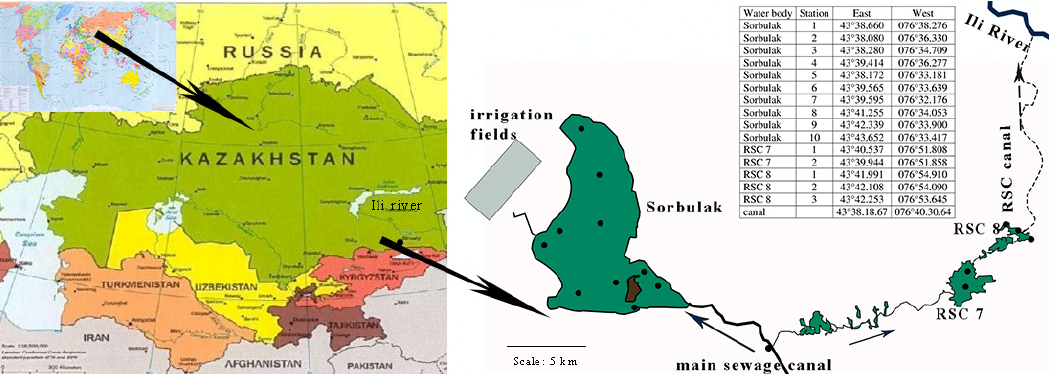
Figure 1. The layout and coordinates of sampling stations in wastewater reservoirs of the Right-Bank Sorbulak Canal system, 2021. Black circles are the sampling stations. The dotted line shows the emergency wastewater canal through which water from RSC 8 can be discharged into the Ili River.